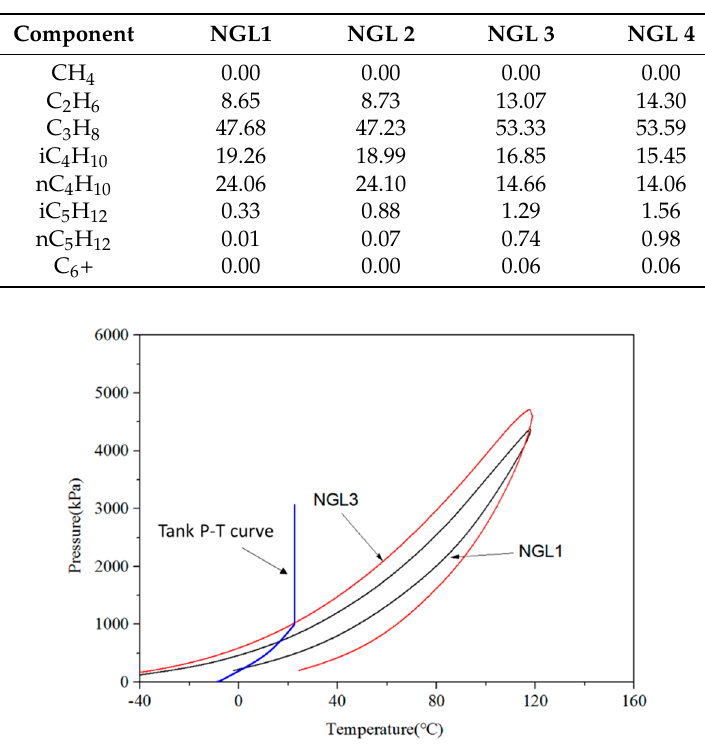
Table 1. Compositions of some NGL mixtures (mol %).